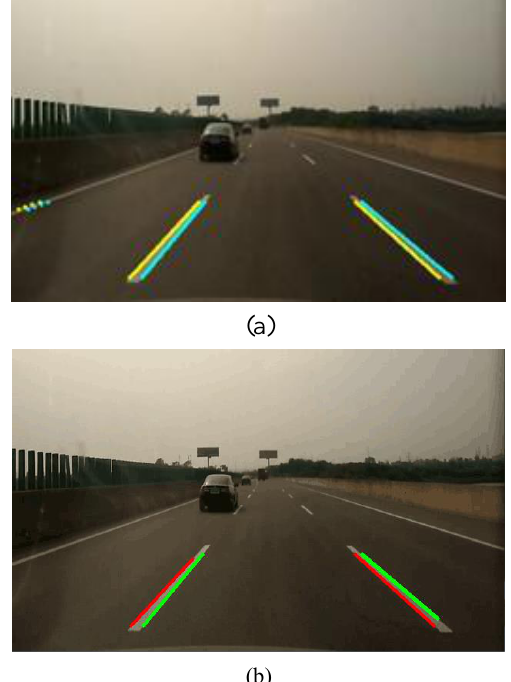
Fig 4. (a) edge points of lane markings. (b) line segment of lane